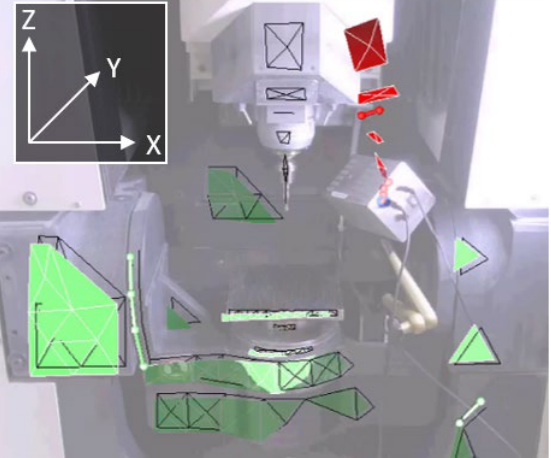
Fig. 4. Example of a measurement image for the evaluation of an occurring